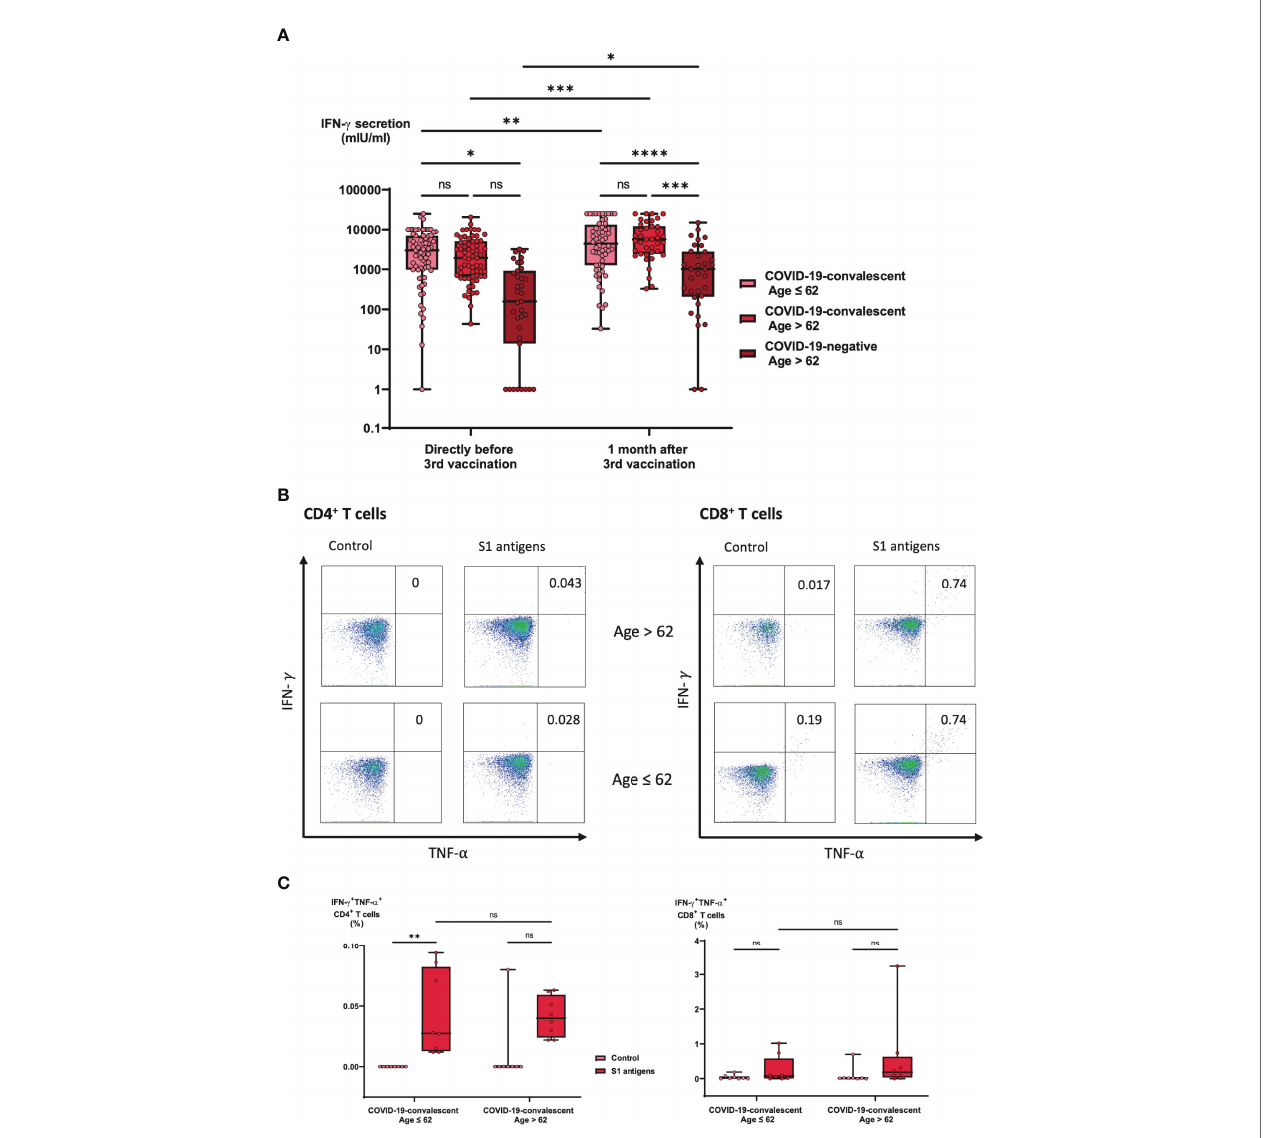
FIGURE 5 | Impact of age and previous SARS-CoV-2 infection on SARS-CoV-2-speci fi c T cell response after booster vaccination. (A) Heparin blood samples from 73 COVID-19-convalescent individuals under the age of 63, 74 COVID-19-convalescent individuals above the age of 62 and 39 individuals above the age of 62, who never had a SARS-CoV-2 infection were collected directly before and one month after booster vaccination with BNT162b2. Heparin samples were incubated overnight with a SARS-CoV-2-spike peptide mixture as described in the Methods Section. Then, supernatants were harvested and IFN-g concentrations measured by ELISA. Box blots show IFN-g concentrations in the three study cohorts before and after vaccination as indicated. Box central horizontal lines indicate medians, box borders represent IQR, whiskers indicate minima and maxima. (B, C) Heparinized whole blood from COVID-19-convalescent individuals one month after booster vaccination with BNT162b2 was stimulated for 18 hours in both control tubes and Quan-T-cell tubes coated containing a SARS-CoV-2-spike peptide mix as described in the Methods section. After incubation, cells were harvested, stained and analyzed using multi-parameter FACS analysis. Panel (B) shows representative percentages of IFN-g + TNF-a + cells in the CD4 + T helper (left panel side) and the CD8 + cytotoxic T cell (right panel side) populations, both in a convalescent individual > 62 years (upper plots) and a convalescent individual ≤ 62 years of age (lower plots). Box blots in panel (C) show average IFN-g + TNF-a + percentages in 8 different individuals > 62 years and in 8 different individuals ≤ 62 years of age. Box central horizontal lines indicate medians, box borders represent IQR, whiskers indicate minima and maxima. Signi fi cance levels were *p < 0.05, **p < 0.005, ***p < 0.0005 and ****p < 0.00005. IFN-g, interferon gamma; IQR, interquartile ranges; ns, not signi fi cant; S1, spike protein 1; TNF-a, Tumor-necrosis-factor